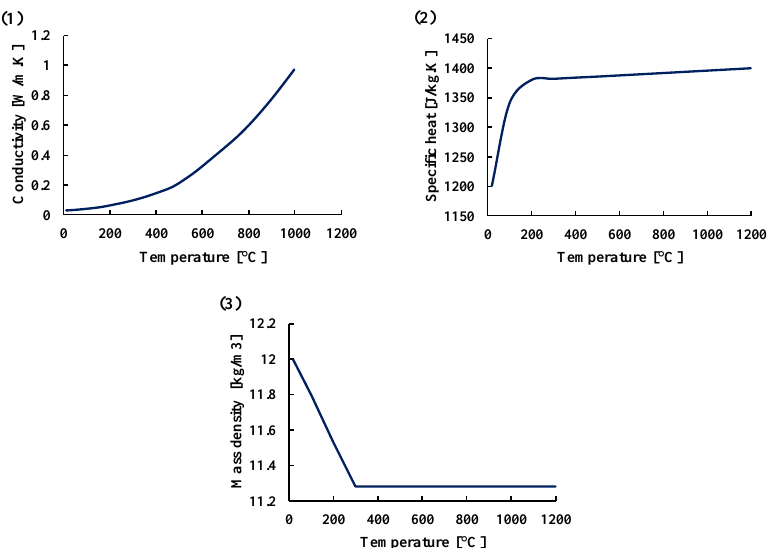
Figure 6. Variation of thermal properties of concrete and carbon steel. Subfigures (1) in subfigures ( a , b ) of Figure 6 represent the variation of conductivity with temperature for concrete and carbon steel respectively. Subfigures (2) in subfigures ( a , b ) of Figure 6 represent the variation of specific heat with temperature for concrete and carbon steel respectively. Subfigure (3) in subfigure ( a ) of Figure 6 represent the variation of mass density of concrete with temperature.